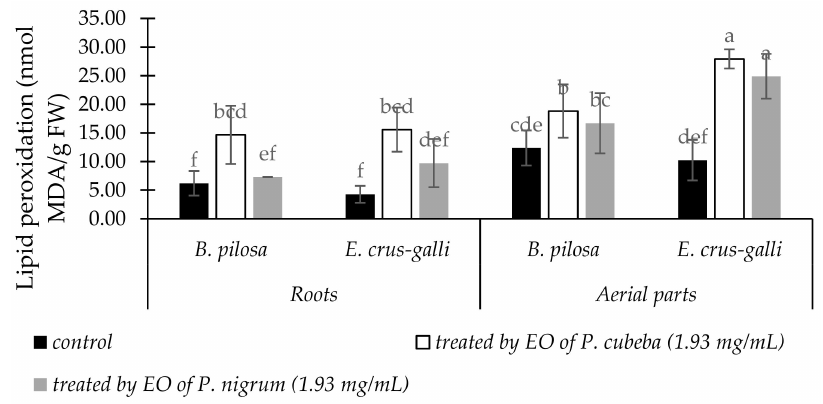
Figure 3. The changes of MDA content between treated and untreated of B. pilosa and E. crus-galli by EOs. Data were presented in means ± standard deviations (SD). Means with di ff erent small letter indicted significantly di ff erent by Fisher’s test ( p < 0.05).